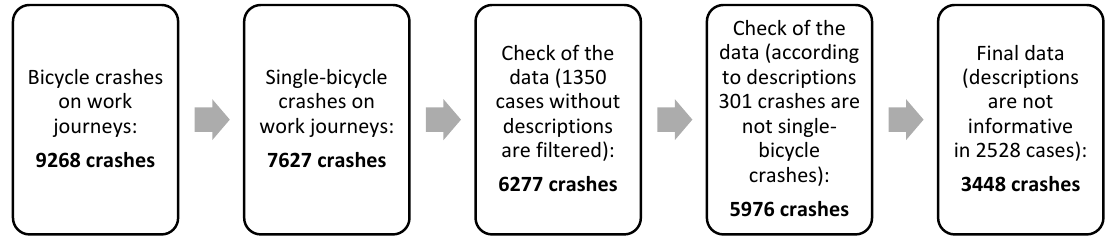
Figure 1. Stages in the formation of the data of single-bicycle crashes.